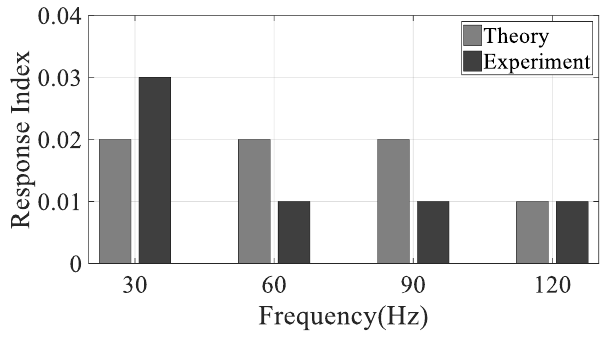
Figure 9. Comparison of response index at the elect power plant location.